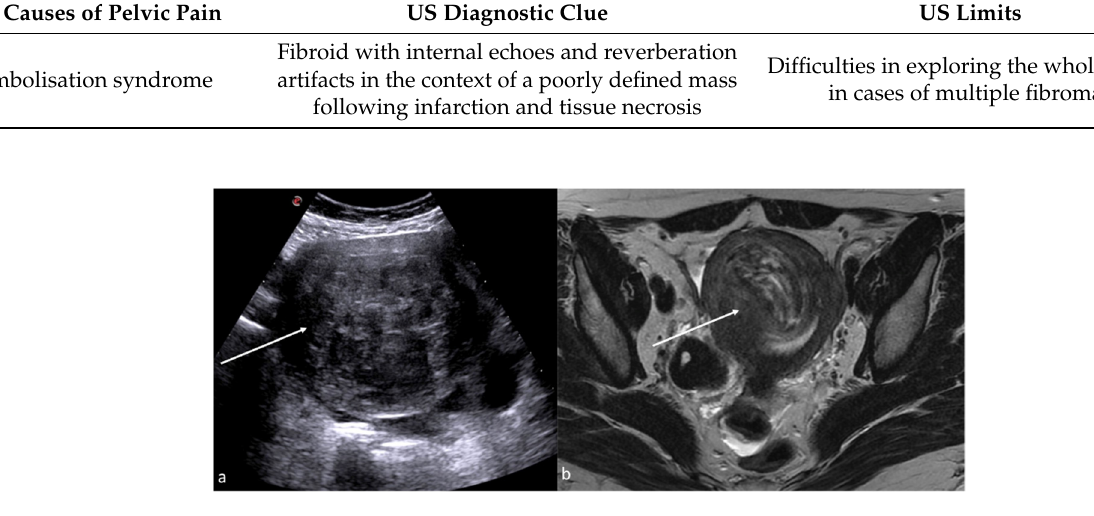
Table 11. Post-embolisation syndrome US diagnostic clue.